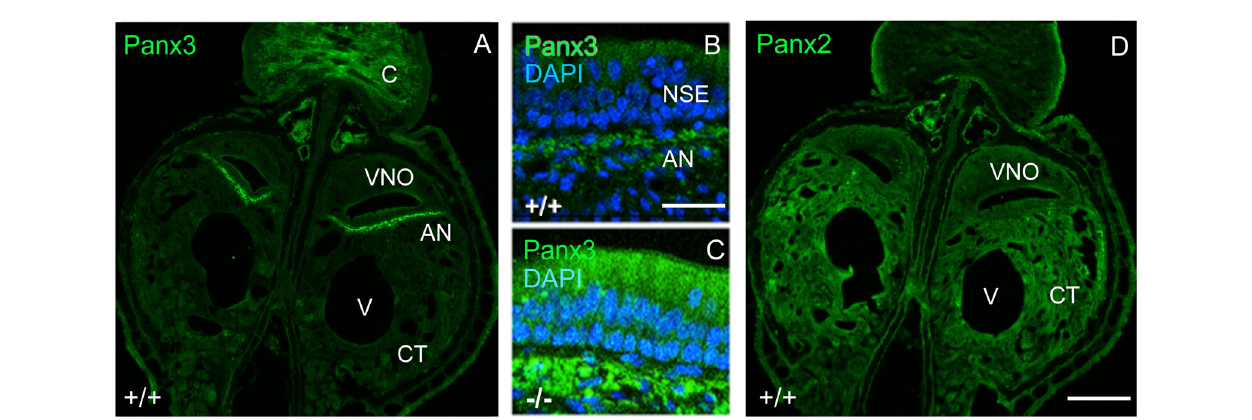
FIGURE 3 | Localization of mPanx2 and mPanx3 proteins showing upregulation of mPanx3 in the NSE of juvenile Panx1 − / − mice. (A) The left panel demonstrates an overview taken at 10x magnification showing the entire VNO and surrounding structures after Panx3 immunostaining. Mouse Panx3 has increased expression where mPanx1 has been demonstrated previously to be found, basal to the NSE, in the autonomous sensory nerve. There is also increased expression in the cartilaginous zone, which is characteristic of mPanx3. (B,C) The two panels in the middle show higher magnifications (63 × ) of the region indicated by the white box, demonstrating some mPanx3 expression in the cilia of the NSE and cell bodies basal to the NSE in wild-type mice. (C) The panel below shows that there is a clear increase in mPanx3 expression in Panx1 − / − in the same regions. (D) Mouse Panx2 is ubiquitously localized in the VNO and the CT. Abbreviations: VNO, vomeronasal organ; V, vasculature; CT, cavernous tissue; C, cartilage; NSE, non-sensory epithelium; AN, autonomous (parasympathetic/sympathetic) nerve; +/+ = WT, − / − = Panx1 knockout (KO). Scale bars 10 × overviews = 350 µ m, 63 × magnifications = 50 µ